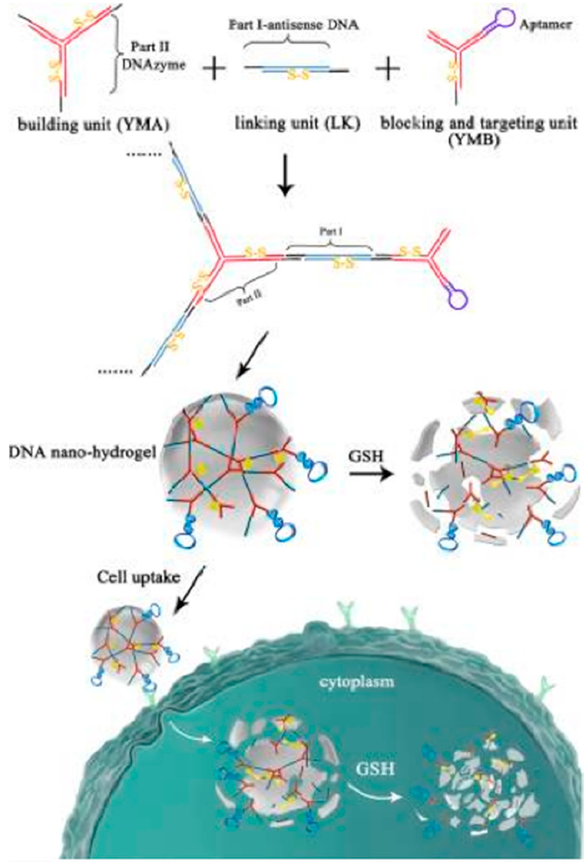
Figure 10. Schematic illustration of DNA nanohydrogels incorporating aptamers for effective targeted gene therapy. Reprinted with permission from © (2015) American Chemical Society [72].